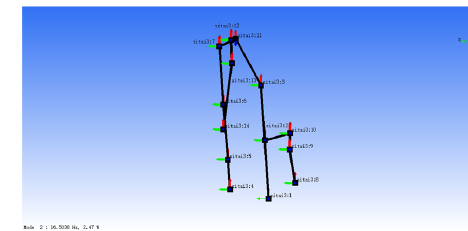
Figure 3. ( a ) First-order simulation mode diagram; ( b ) First-order test mode diagram.